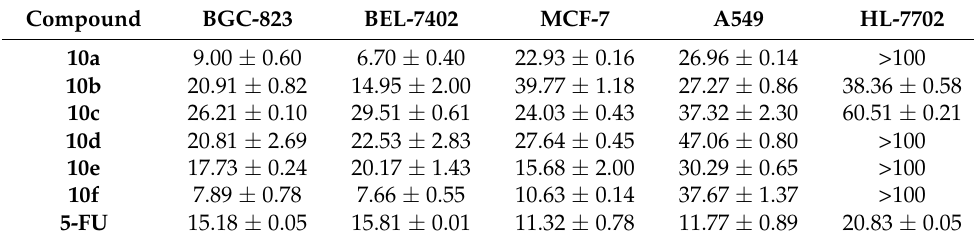
Table 1. The IC 50 values of 10a – 10f against the selected cells for 48 h ( µ M).